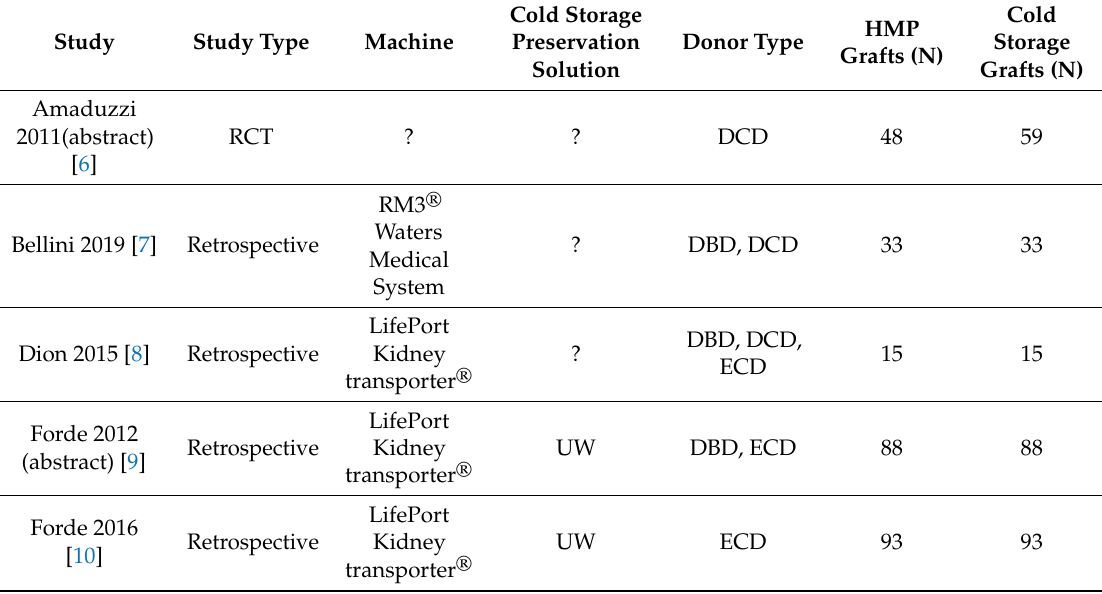
Table 2. StudiescomparingHMPandSCSinkidneys. Abbreviations: Table 2. Studies comparing HMP and SCS in kidneys. Abbreviations: HTK: Histidine-tryptophan-